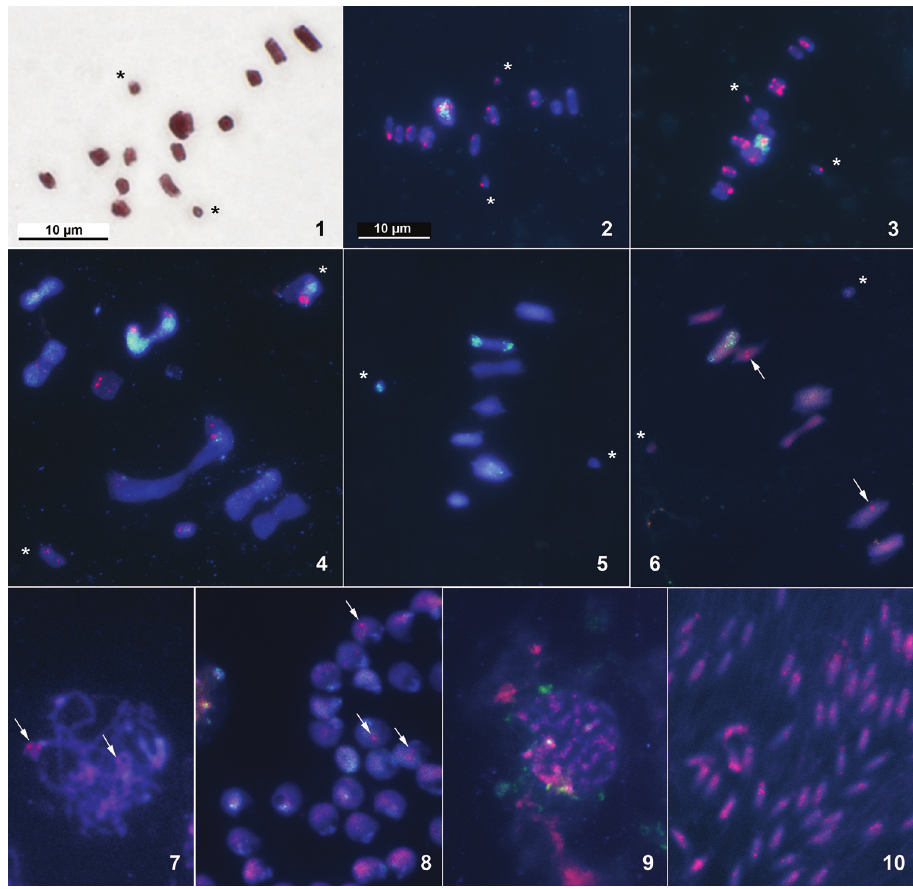
Figures 1–10. Different stages of spermatogenesis in antlion species Palpares libelluloides ( 1–3 ), Acanthaclisis occitanica ( 4 ), Distoleon tetragrammicus ( 5–8 ) and owlfly species Libelloides macaronius ( 9–10 ) after standard staining ( 1 ) and FISH with the 18S rDNA and telomeric (TTAGG) Y 4 diakinesis/MI transition, n = 8 + X + Y 5, 6 MI, n = 7 + X + Y 7 pachytene 8 spermatids 9 mitotic meta- phase 10 spermatids. Asterisks mark sex chromosomes; red signals identify the (TTAGG) (arrowed); green signals identify rDNA clusters. Scale bar on Fig. 2 also applies to Figs